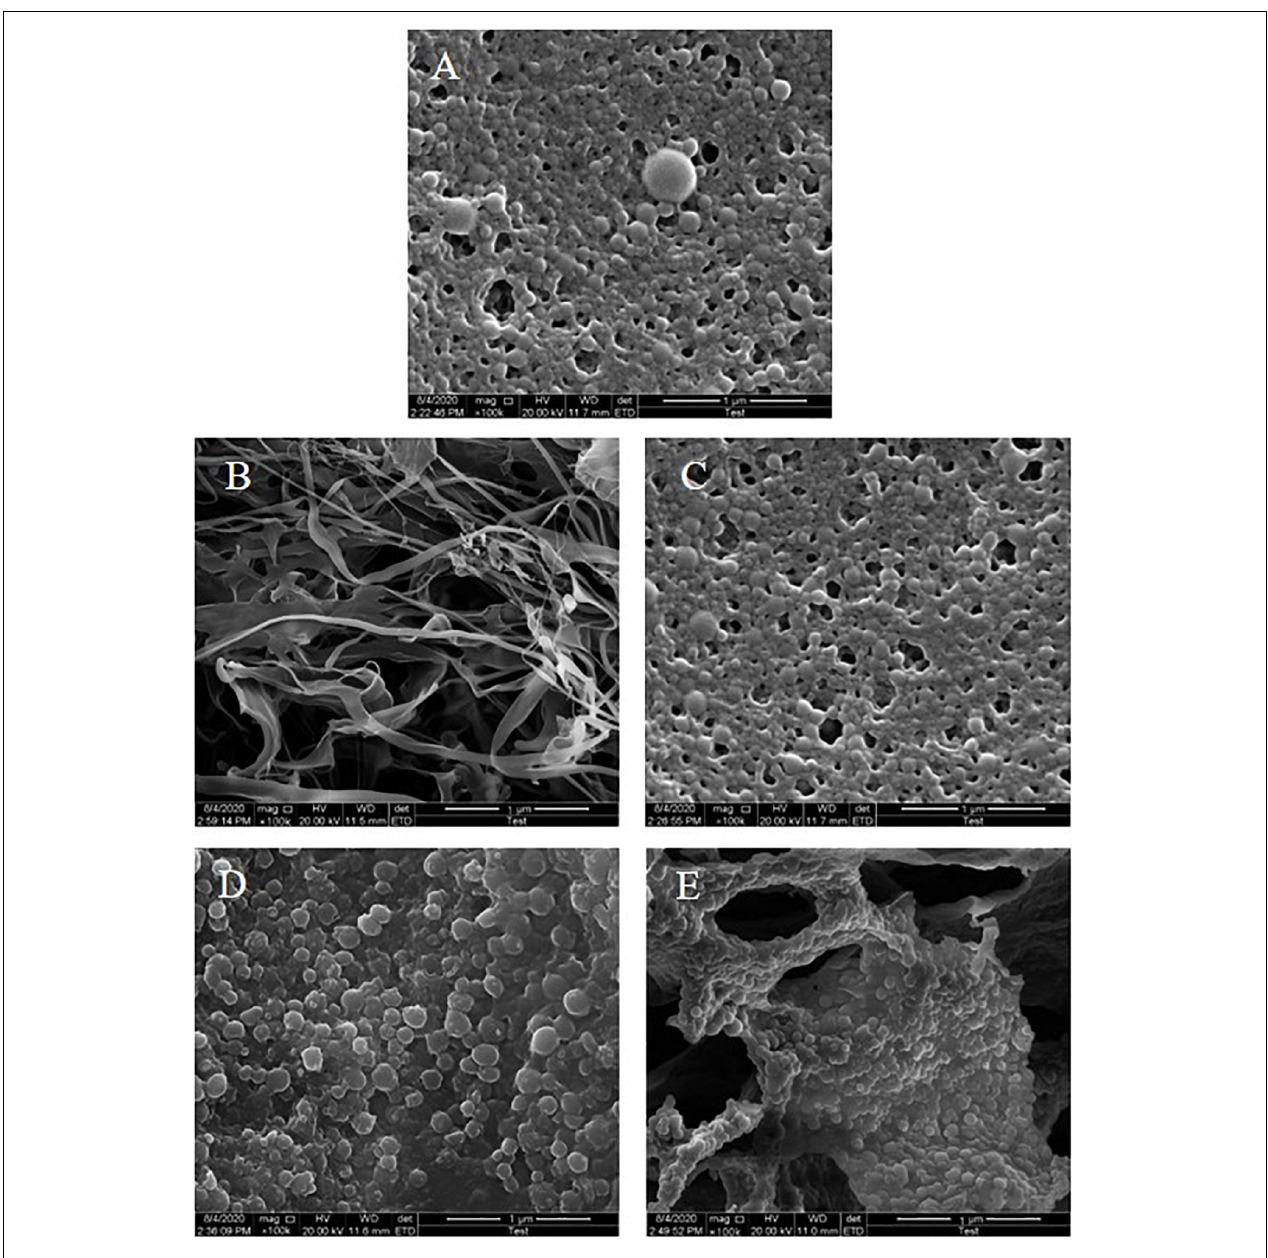
FIGURE 3 | Scanning electron microscopy (SEM) images of composite colloidal particles ( A: ZCPs, B: KGM, C: ZLCPs, D: ZKCPs, and E: